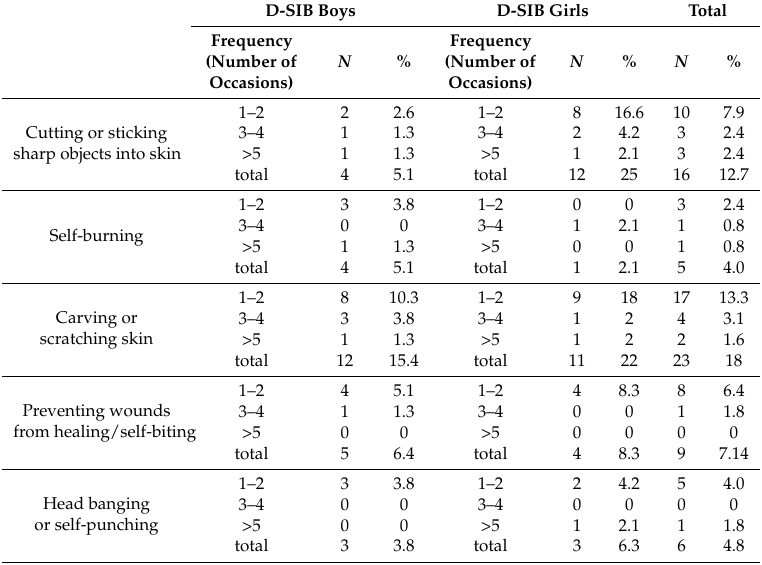
Table 1. Distribution of direct self-injurious behavior (D-SIB) methods types by